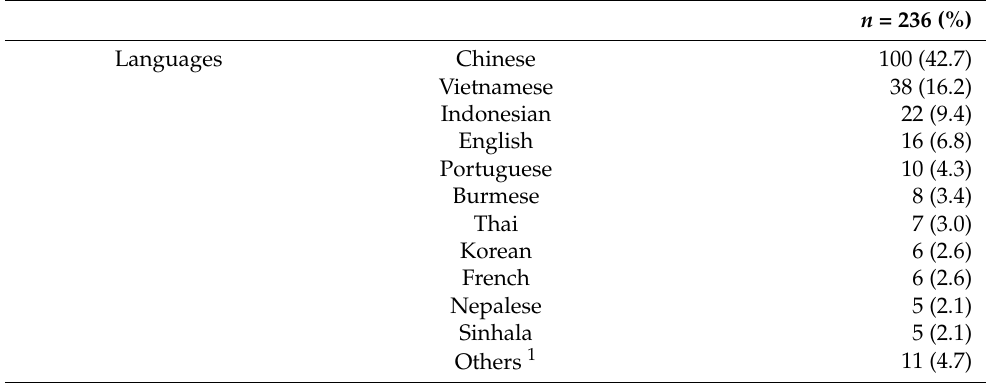
Table 2. Languages used for remote medical